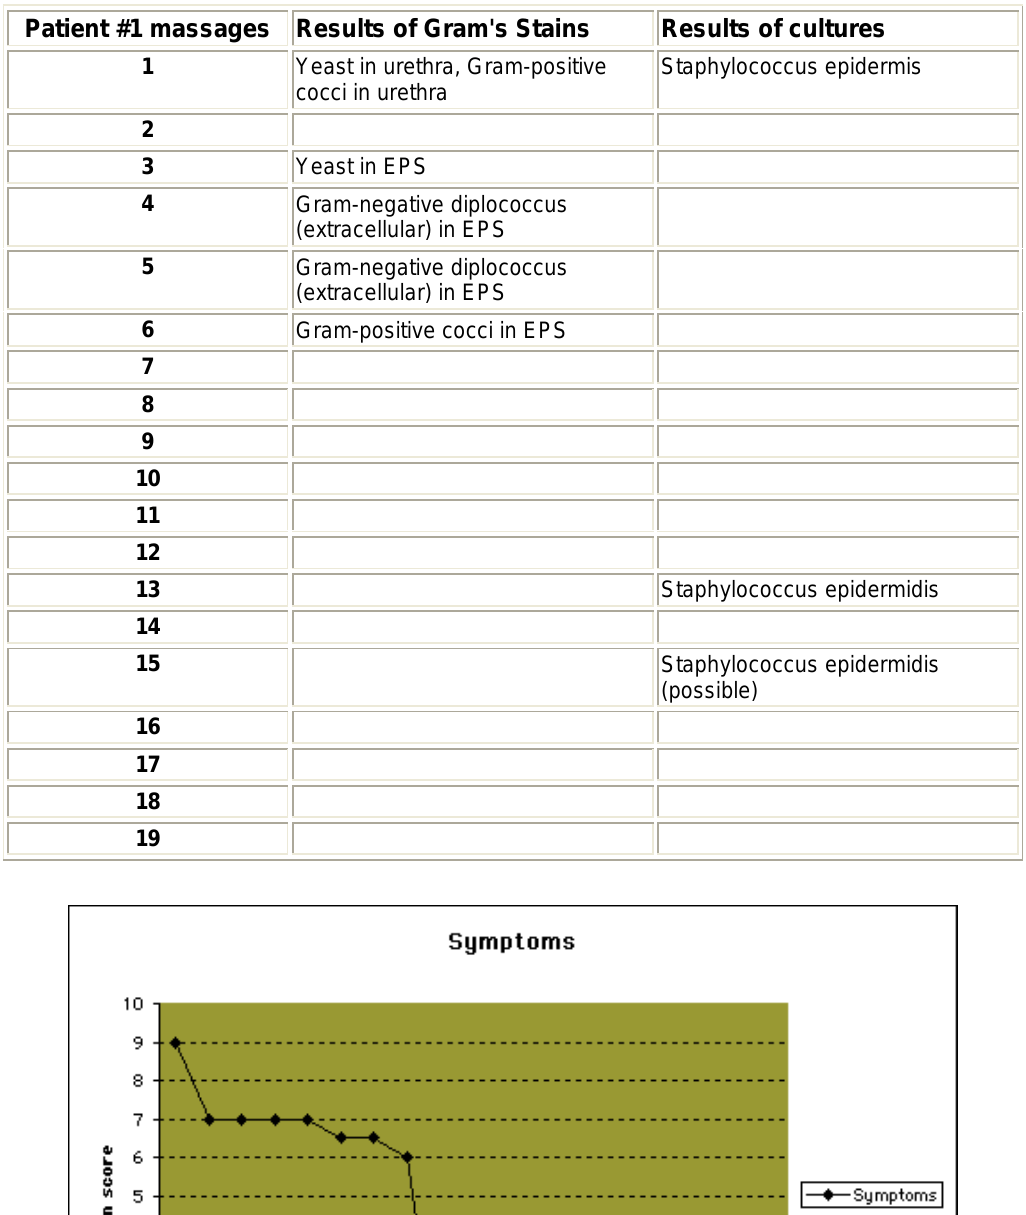
Results of positive Gram stains and cultures for patient #1.